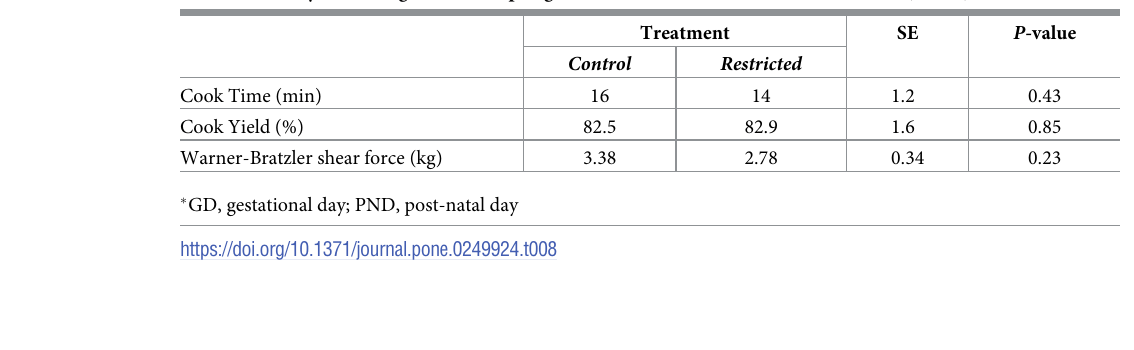
Table 8. Effects of maternal nutritional energy restriction (100% vs 70%) from GD158 to parturition on carcass shear and cook yield of Angus cross offspring fed ad libitum from PND 315 to PND 485 (n =